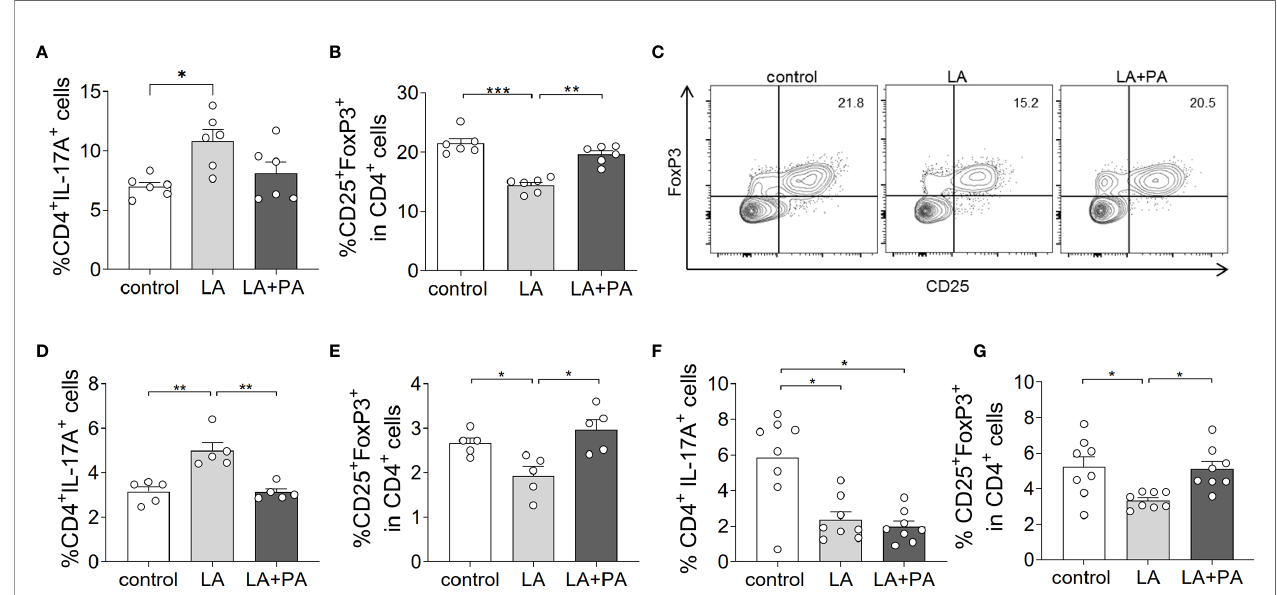
FIGURE 2 | PA treatment reverts the pro-in fl ammatory effect of a LA-rich diet and increases Treg cell frequencies during MOG-EAE. Mice were fed a LA-rich diet or control-diet 4 weeks prior to immunization and were additionally treated with PA (LA+PA) or water (control; LA) by daily oral gavage starting from day 0. (A – C) Ex vivo fl ow cytometry analysis of (A) CD4+IL-17+ Th17 cells and (B) CD25+FoxP3+ Treg cells in the spinal cord on day 21 of EAE (n=6 per group). (C) Representative fl ow cytometry images of CD25+FoxP3+ Treg cells in the spinal cord on day 21 of EAE. (D, E) Ex vivo fl ow cytometry analysis of (D) CD4+IL-17+ Th17 cells and (E) CD25+FoxP3+ Treg cells in the spleen on day 10 of EAE (n=5 per group). (F, G) Ex vivo fl ow cytometry analysis of (F) CD4+IL-17+ Th17 cells and (G) CD25+FoxP3+ Treg cells in the small intestine on day 3 of EAE (n=8 per group). *p<0.05, **p<0.01, ***p<0.001 using one-way ANOVA and Tukey ’ s posthoc